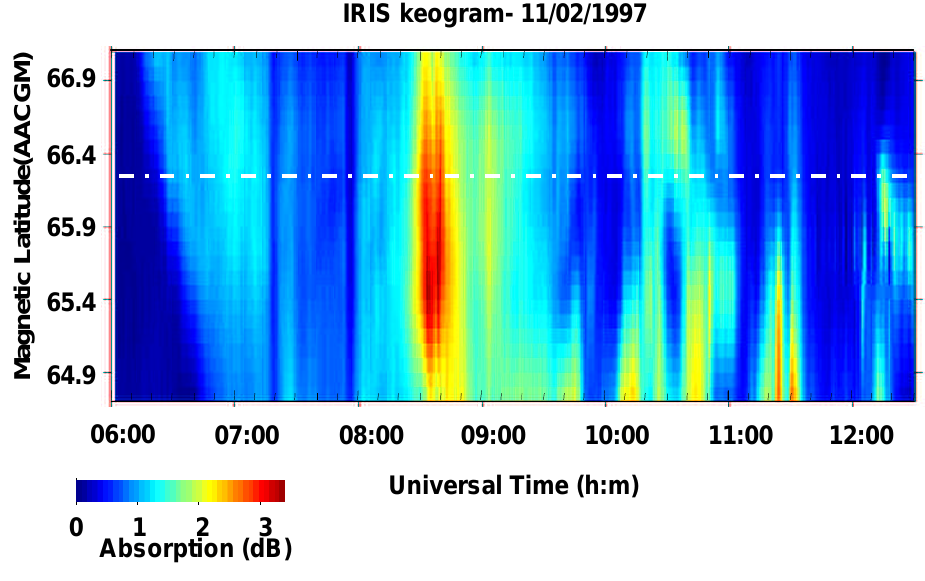
Fig. 6. Keogram taken at constant geographic longitude. The image is a composite from the IRIS beam data and includes beam 16 that overlaps the field aligned EISCAT radar beam in the D-region. The dashed white line indicates the latitude of EISCAT.